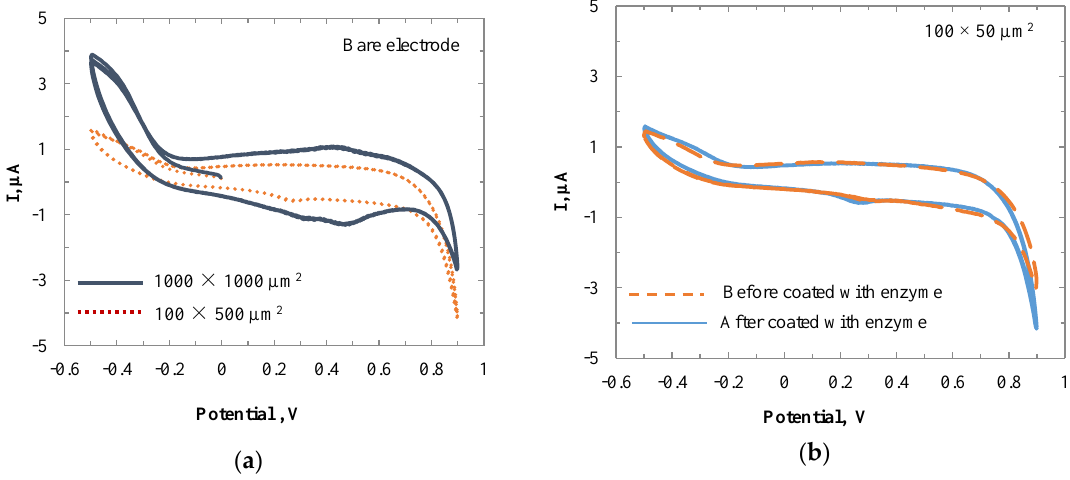
Figure 2. Cyclic voltammograms of ( a ) bare gold electrodes with the sizes of 1000 × 1000 μm and 100 × 50 μm; and ( b ) the sensor with a size of 100 × 50 μm in PBS with 150 mM KCl before and after enzyme coating.